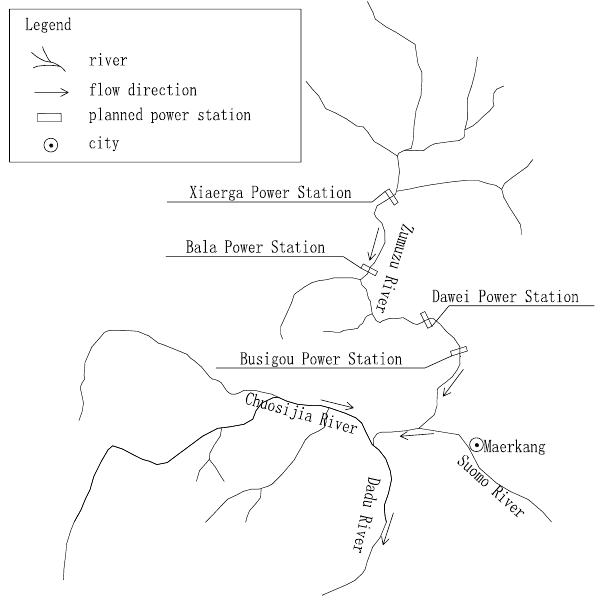
Fig. 1. The cascades on Zumuzu